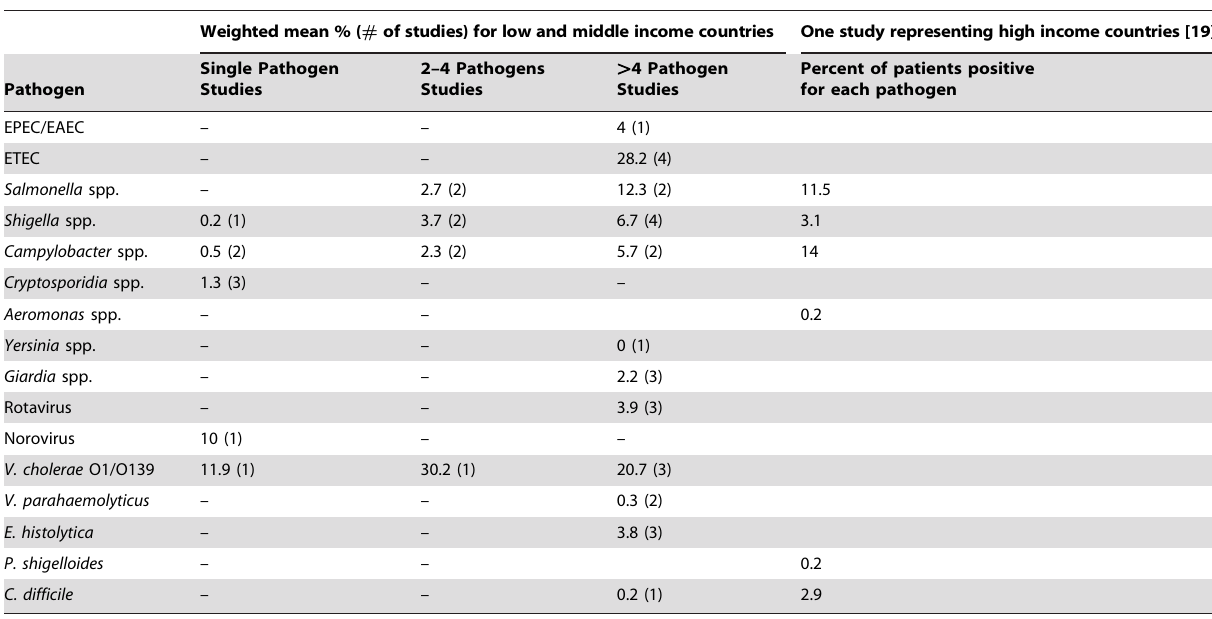
Table 5. Isolation of single vs. multiple pathogens among